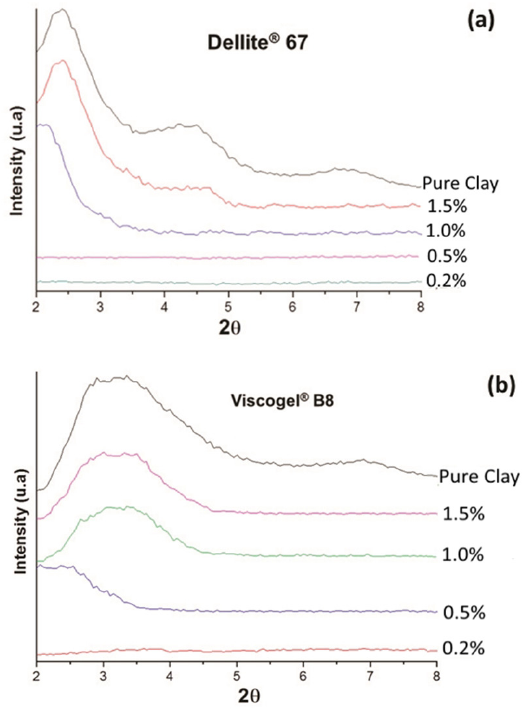
Figure 1. Diffractograms of adhesives containing varying concentrations of the clays Dellite 67G (a) and (b) Viscogel B8